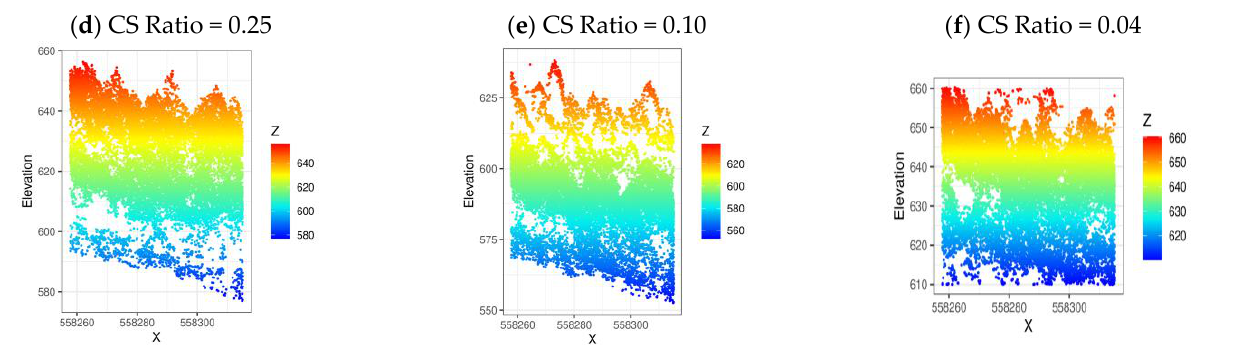
Figure 7. Illustration showing the reconstructed point clouds using the proposed ADCoSNet for different CS ratios for the selected Andrews 1 and Andrews 2 test sites. ( a ) Original; ( b ) CS Ratio = 0.75; ( c ) CS Ratio = 0.50; ( d ) CS Ratio = 0.25; ( e ) CS Ratio = 0.10; ( f ) CS Ratio = 0.04.